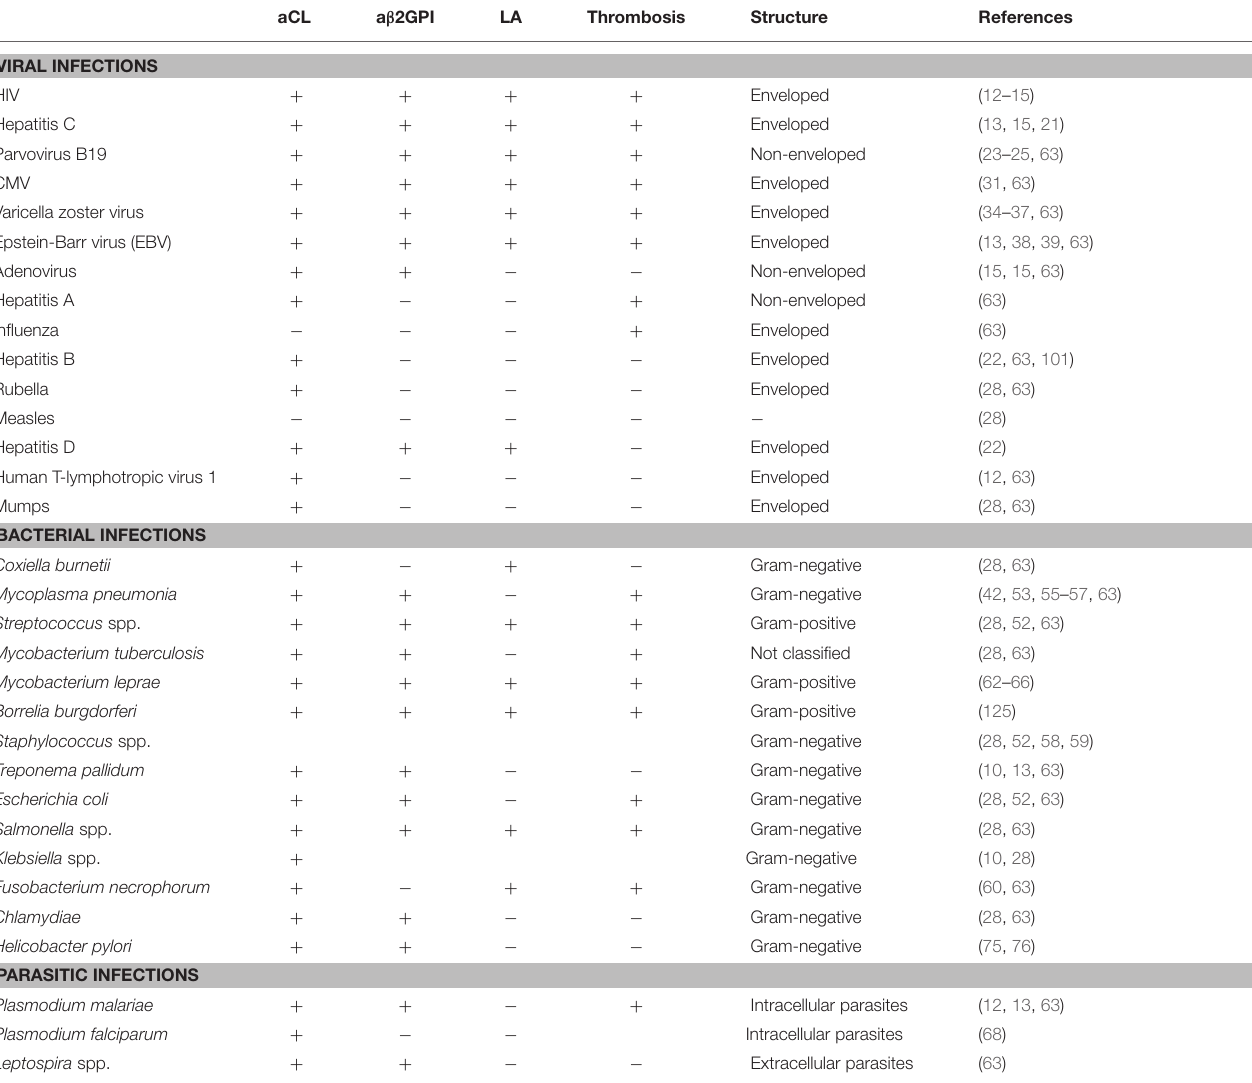
TABLE 1 | Bacterial, viral, and parasitic agents linked to the aPL production and clinical manifestation. aCL a β 2GPI LA